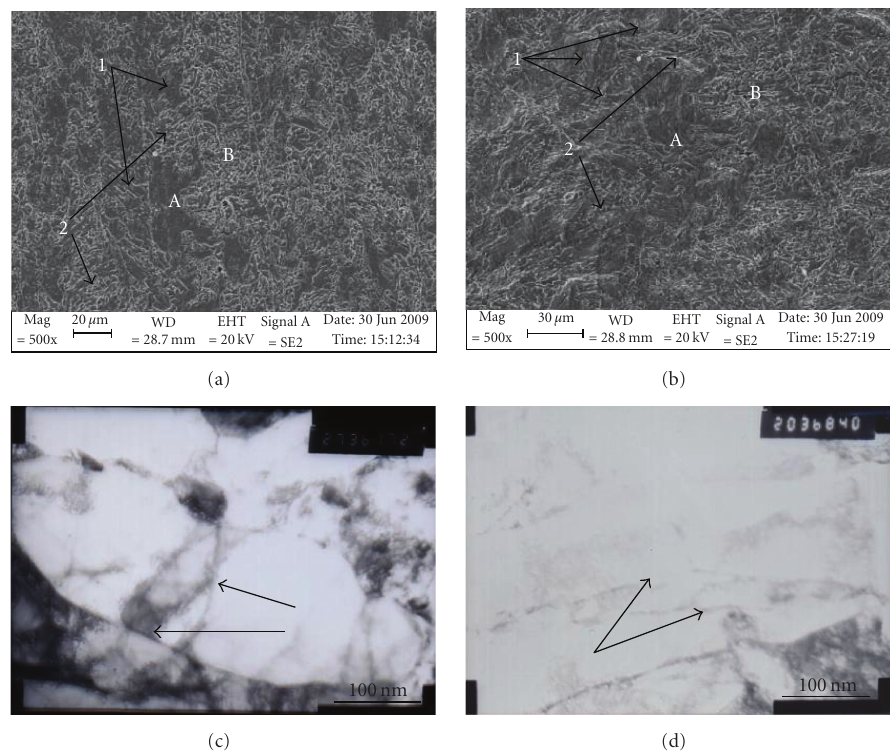
Figure 3: SEM and TEM pictures of quasipolygon ferrite microstructure transformation (a) original (b), (c), and (d) after